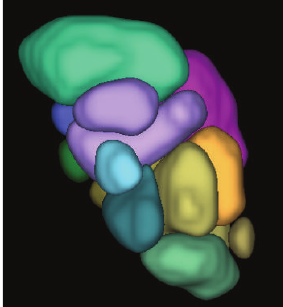
Figure 5: A 3D view of the thalamus nuclei segmentation